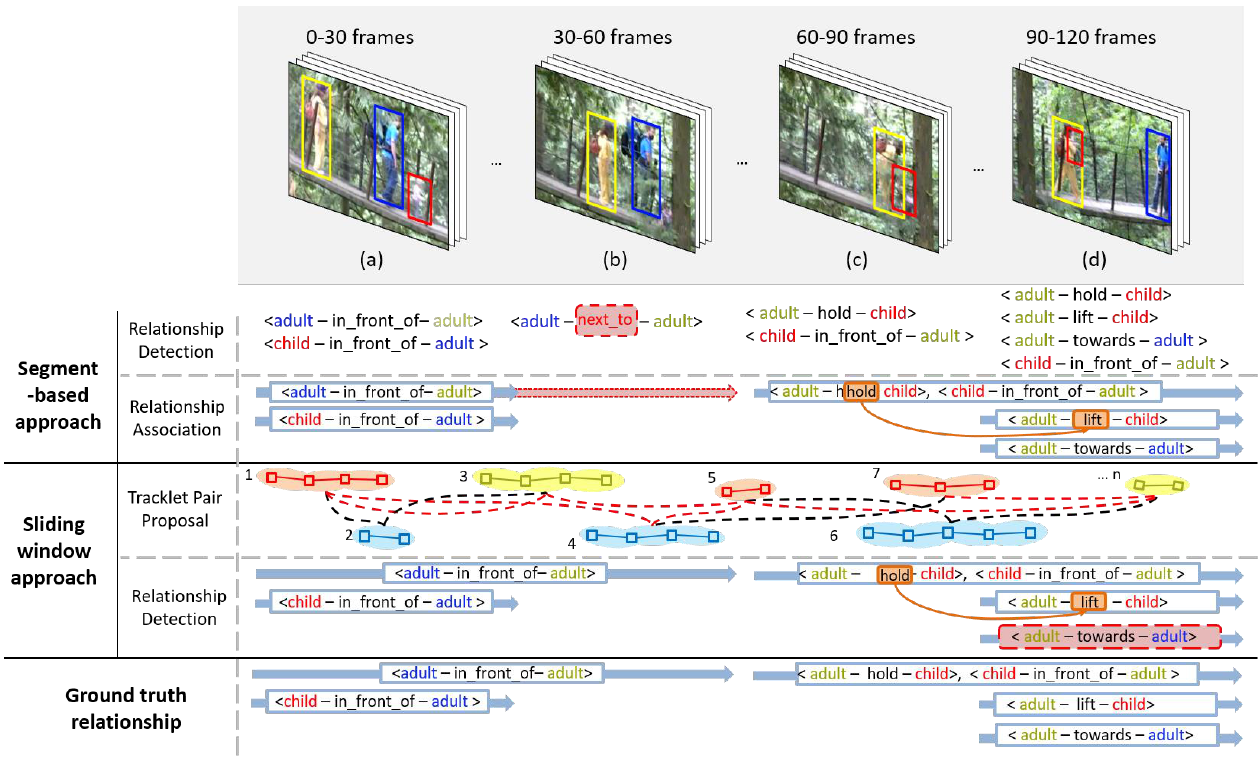
Figure 1. Different approaches to video scene graph